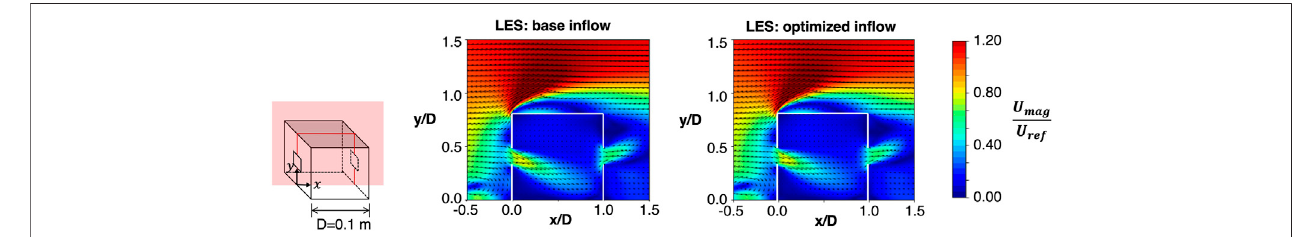
FIGURE 9 | Velocity magnitude contour with quiver plot for fl ow direction using the base in fl ow (left) and optimized in fl ow (right).